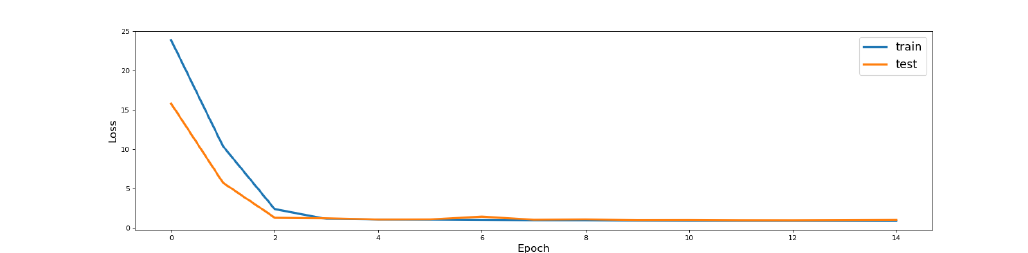
Figure 10. Learning curve of a GRU model, showing the loss measured in the train and test set during the first 14 epochs.